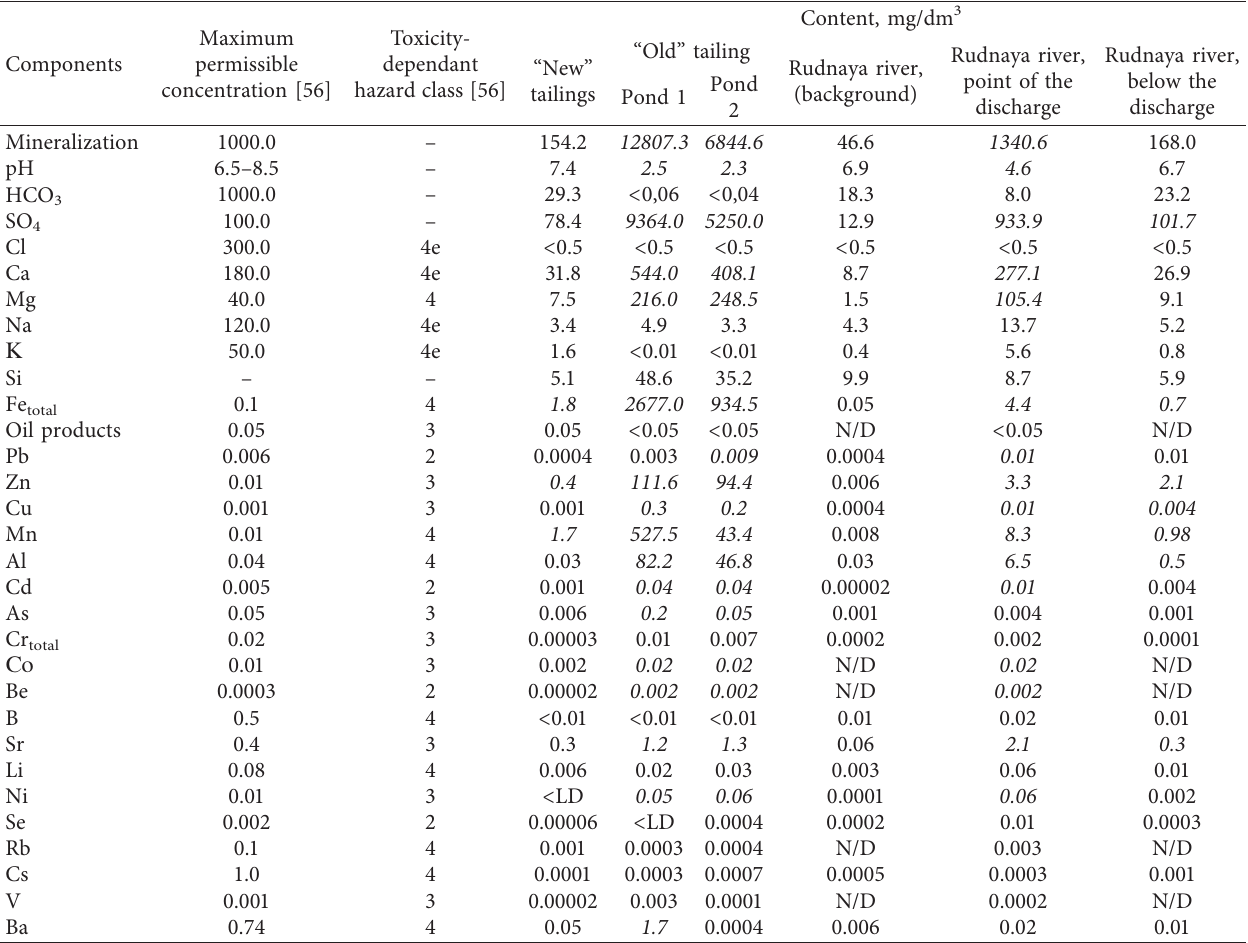
Table 2: The chemical composition of the water in the tailings ponds of